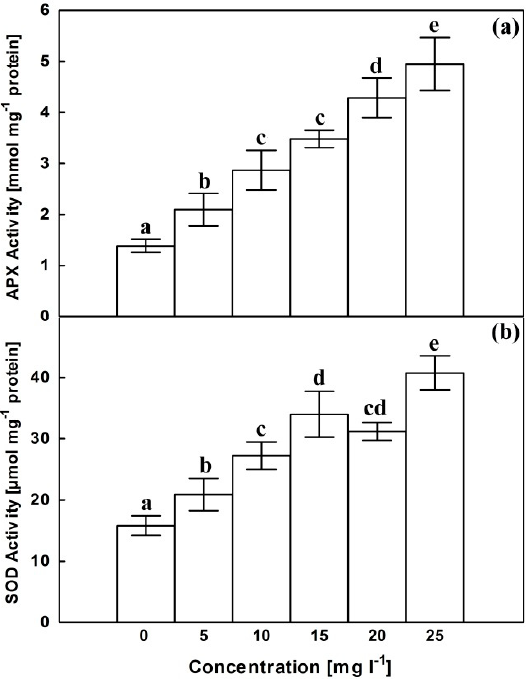
Figure 5. Effects of AgNPs at concentrations of 5, 10, 15, 20 and 25 mg L − 1 on APX activity ( a ) and SOD activity ( b ) of C. roseus cell suspension cultures. Means ± standard deviations (SDs), n = 3, Values followed by the same small letter within each column are not significantly different at p ≤ 0.05.